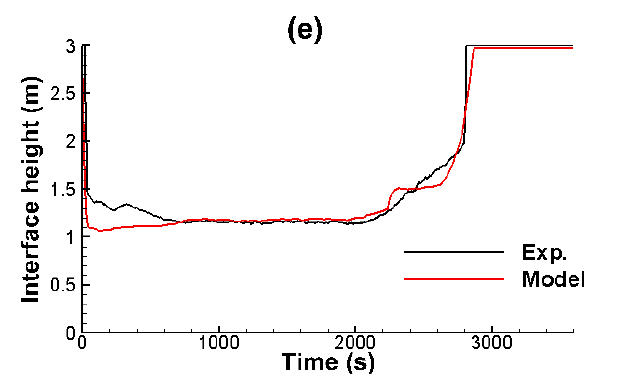
Figure 18. Test 10: ( a ) individual and total HRRs, ( b ) average gas temperature, ( c ) average wall temperatures, ( d ) volume fractions of O 2 and CO 2 in the exhausted gases, and ( e ) smoke layer interface height.